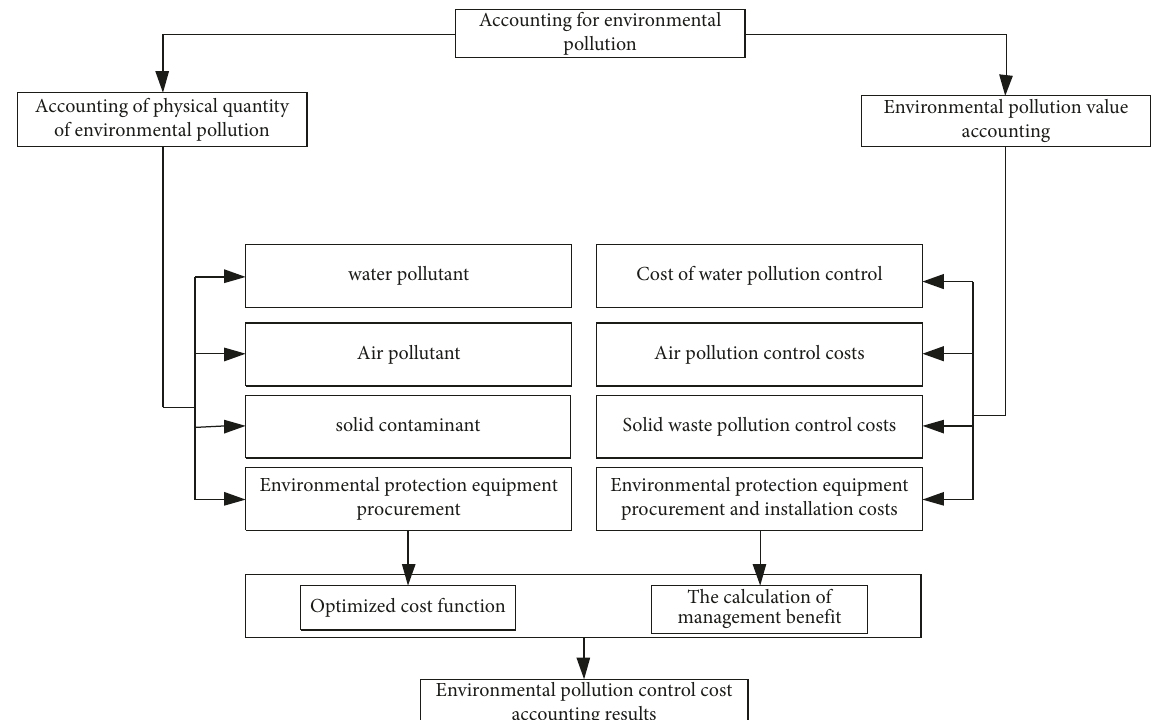
Figure 1: Cost accounting algorithm architecture of ecological environment pollution